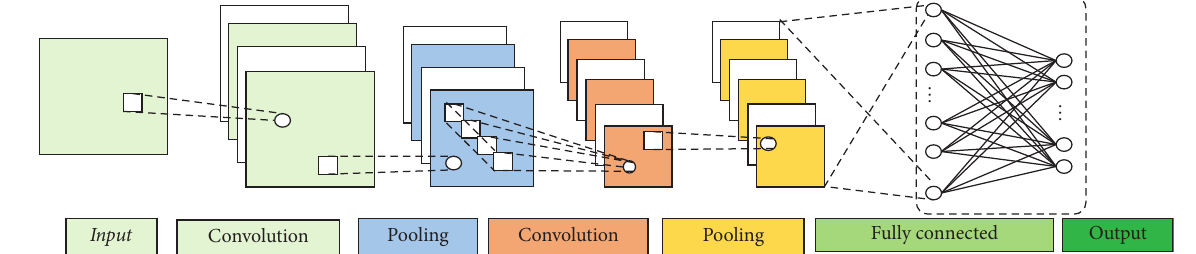
Figure 5: Convolutional neural network (CNN) structure